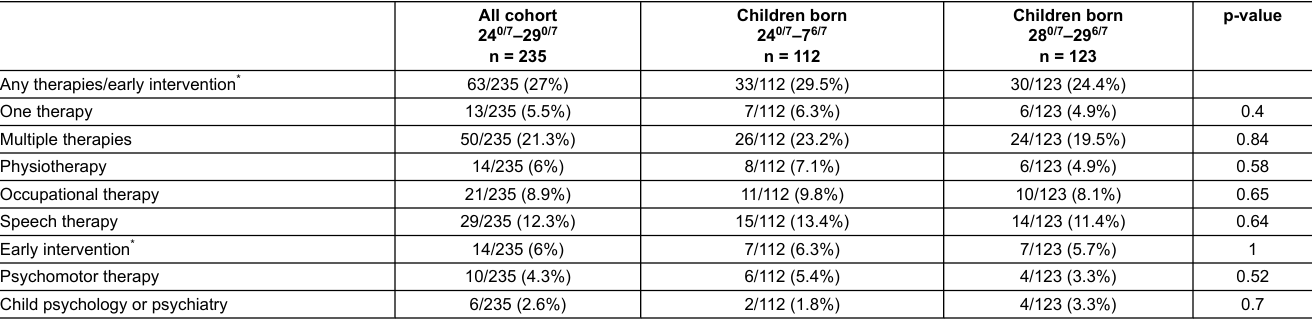
Table 4: Early intervention and therapies at early school age by gestational age